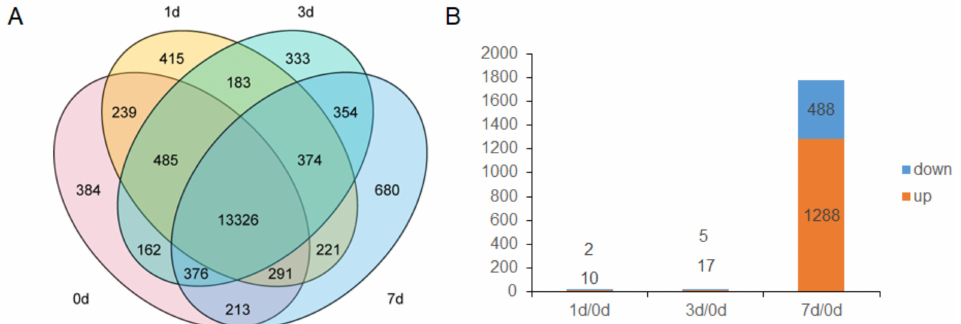
Figure 2. DEGs of different incubation time points of Vitis davidii Föex berries. ( A ) Venn diagram analysis of gene expression at different incubation time points. ( B ) Number of different gene ex- pressions at different incubation time points. Orange bar represents up-regulated genes; blue bar represents down-regulated